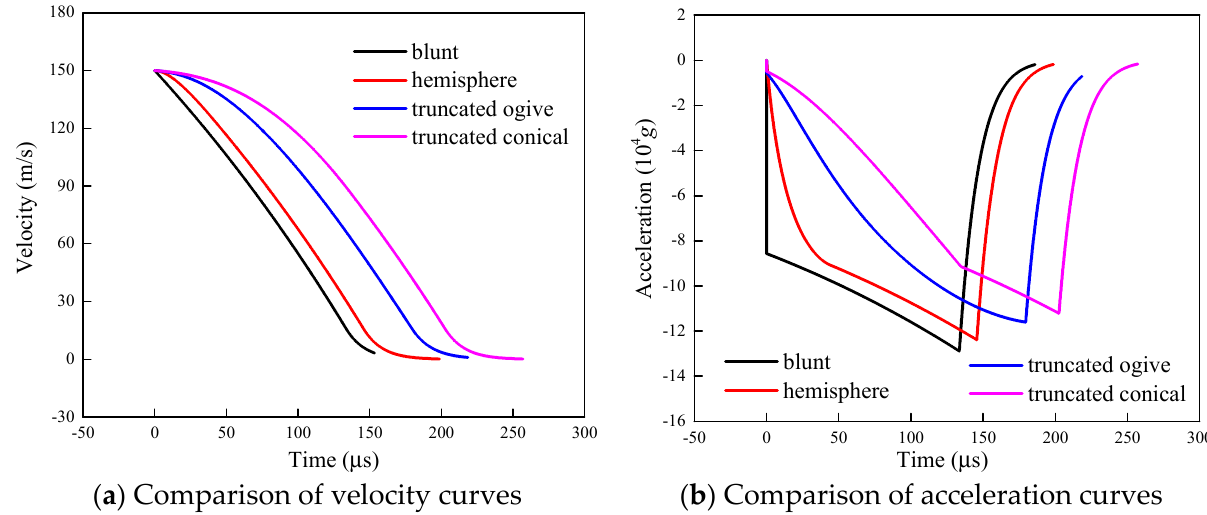
Figure 24. Time history curve comparison during the impact of the different nose-shape projectiles. According to the Taylor impact theory, the velocity variation of the projectile is caused by back-and-forth propagation within the projectile of the elastic wave generated by the nose impact. As the nose shape changes, the propagation path of the elastic wave in the projectile body changes from the constant section propagation of the blunt projectile to the continuous variable section propagation of the other nose types. According to Equation (13), the stress amplitude decreases with increasing section radius during the propagation of the stress wave, which can reduce the particle velocity in the propagation region. This phenomenon is reflected in the acceleration curve of the projectile body in the form of a slow rising edge at the initial impact stage. Moreover, the variation law of the section radius is determined by the geometric parameters or the shape function of the projectile nose, allowing the particle velocity in the propagation region to slowly decrease. Meanwhile, the acceleration curve can exhibit a rising edge similar to the nose shape. Finally, the variation law of the nose section shape is reflected in the acceleration curve and can affect the entire waveform, which is also the primary reason for the different impact load pulse shapes produced by the different nose